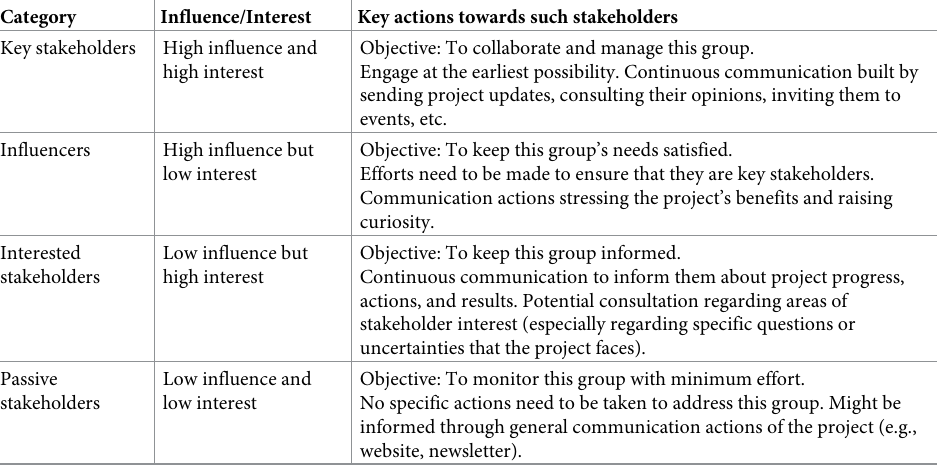
Table 3. Key actions to engage with the different stakeholder